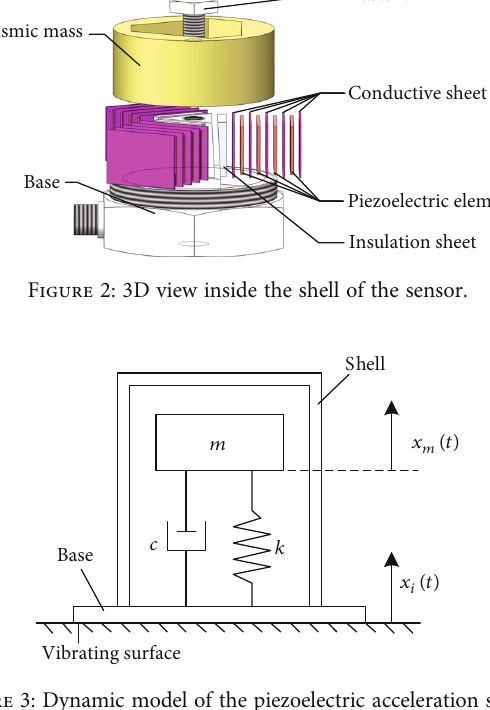
Figure 3: Dynamic model of the piezoelectric acceleration